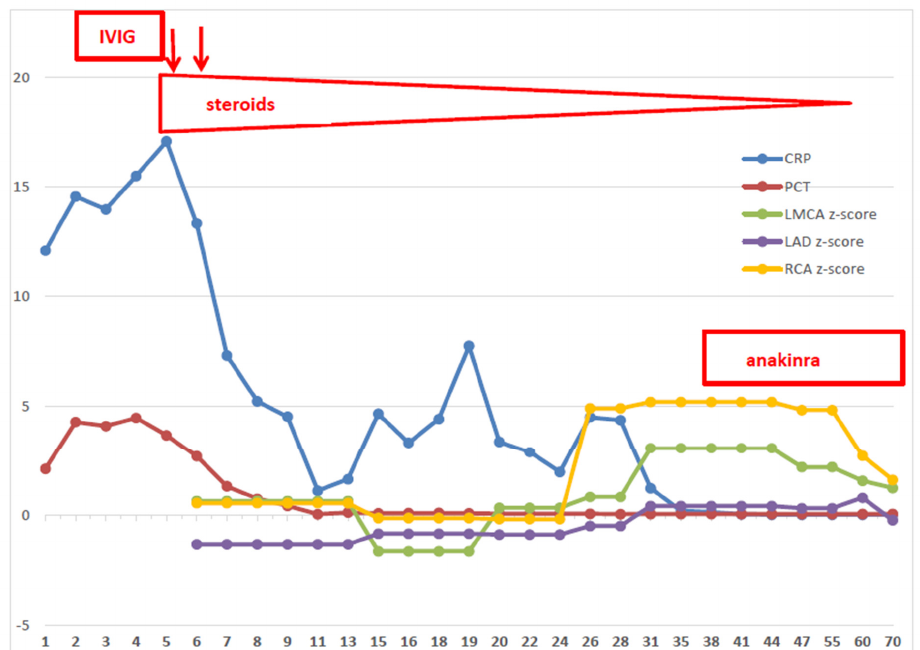
Figure 1. Time course of C-reactive protein, Procalcitonin, coronary arteries and treatments. CRP = C-reactive protein; PCT = procalcitonin; LMCA = left main coronary artery; LAD = left anterior descending artery; RCA = right coronary artery; IVIG = intravenous immunoglobulins.